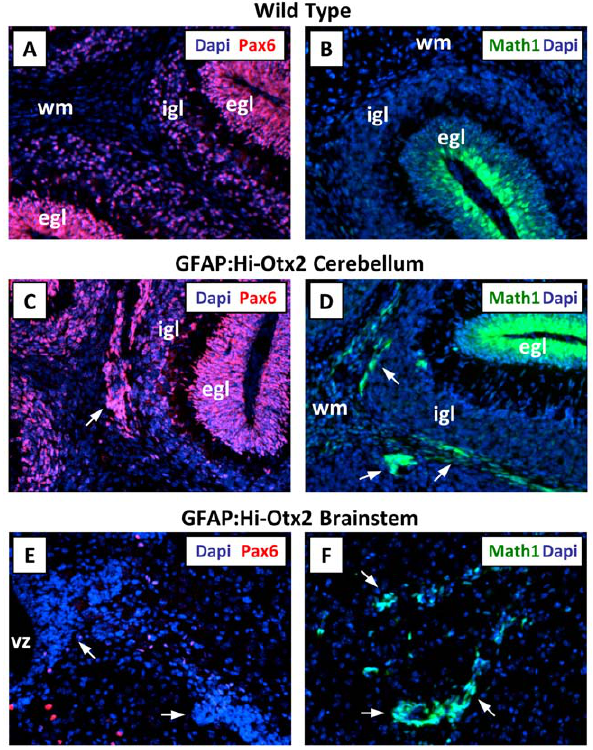
Figure 3. Cerebellar and brainstem ectopia express Math1. (A, C, E) Immunofluorescent staining for Pax6 in (A) wild type cerebellum, (C) GFAP:Hi-Otx2 cerebellum, and (E) GFAP:Hi-Otx2 brainstem. (B) MATH1-GFP reporter expression in the cerebellum of MATH1-GFP transgenic mice. (D, F) MATH1-GFP reporter expression in the (D) cerebellum and (F) brainstem of GFAP:Hi-Otx2, MATH1-GFP mice. 20 6 mag. Arrows indicate ectopia.